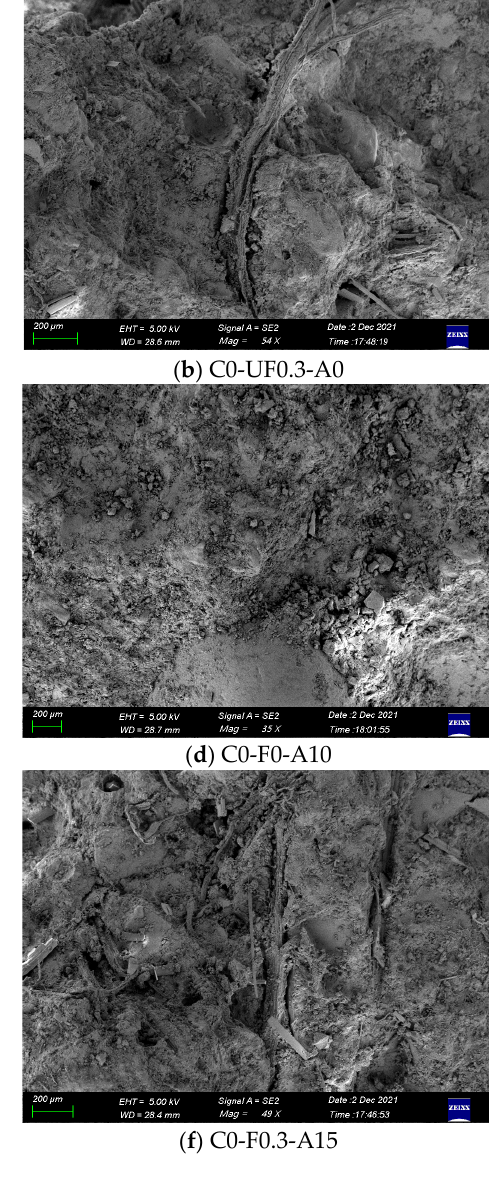
Figure 15. SEM image of cement mortar cured for 28